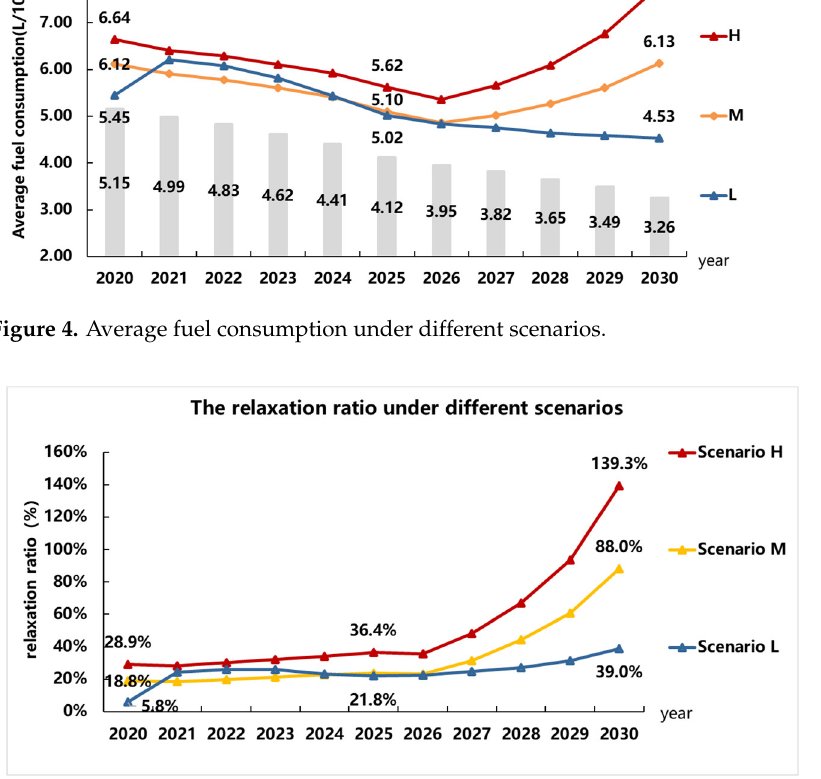
Figure 5. The ratio of the fuel consumption target relaxation.